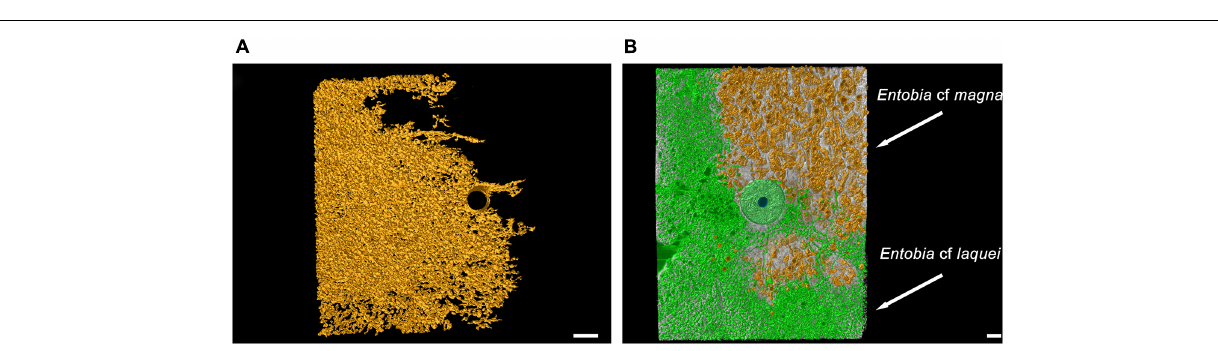
FIGURE 6 | Computed tomography graphic reconstruction of boring sponges’ traces in travertine tiles left by C. rhodensis , in orange, and C. viridis , in green. (A) Entobia cf paradoxa at MR08 after 3 years of exposure. (B) Entobia cf magna and Entobia cf laquei at MR08 after 12 years. The steel washer used to anchor the tile to the seabed, and subsequently incorporated into the bioconstruction, is also visible. Scale bars are 1 cm